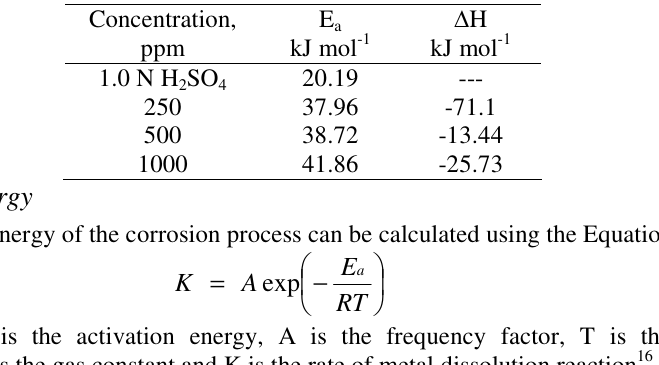
Table 4. Activation parameters at various inhibitor concentrations in 1 N H